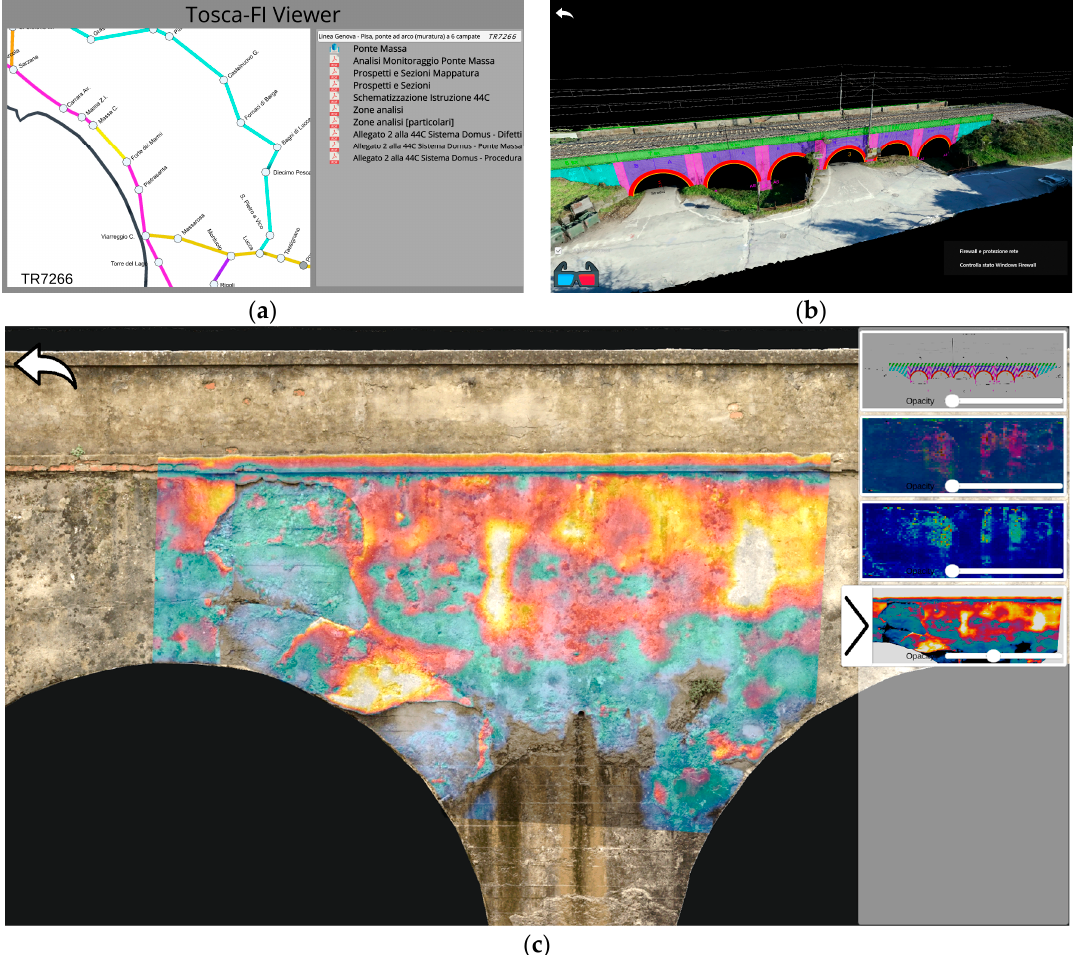
Figure 2. TOSCA-FI platform: ( a ) Railway infrastructure map for selecting the area (and, e.g., railway bridge) of interest; ( b ) 3D reconstruction of the selected structure (bridge); ( c ) thermographic image superimposed to the HD metric digital photos (selectable from the 3D model displayed in the ICT integrated